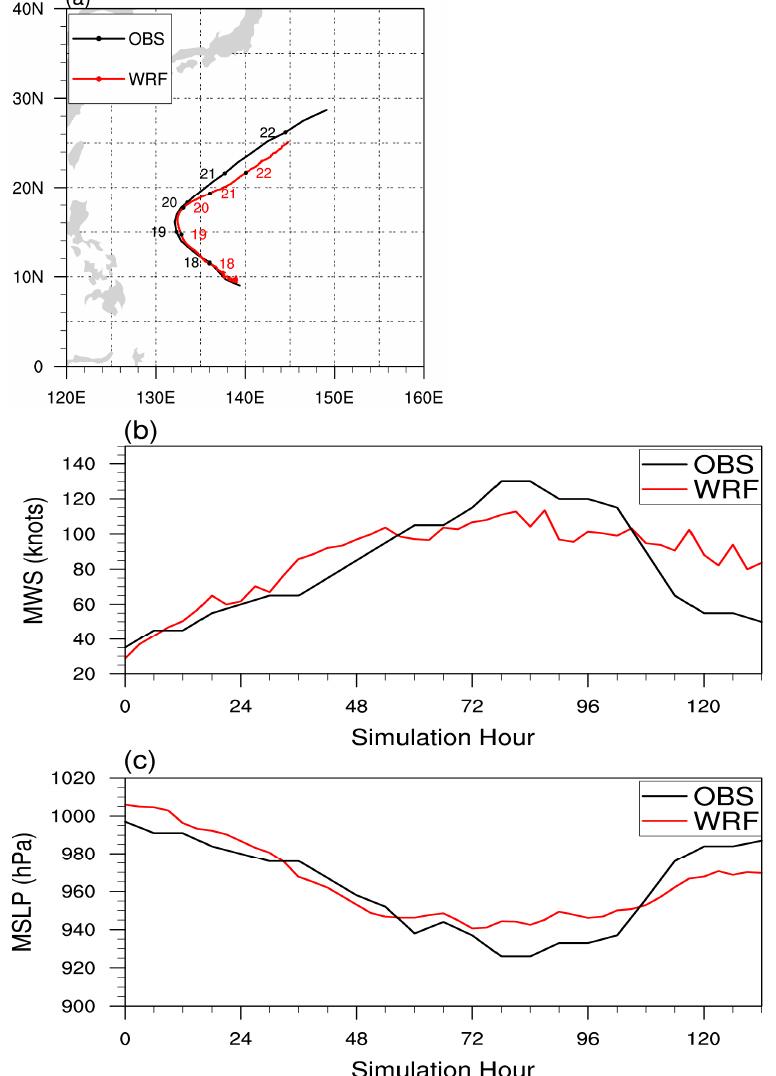
Figure 2. ( a ) Observed and simulated storm tracks. The numbers in ( a ) represent the location of TC at 0000 UTC. Temporal evolutions of ( b ) the TC maximum wind speed (MWS) and ( c ) minimum sea level pressure (MSLP) in the observation and simulation.